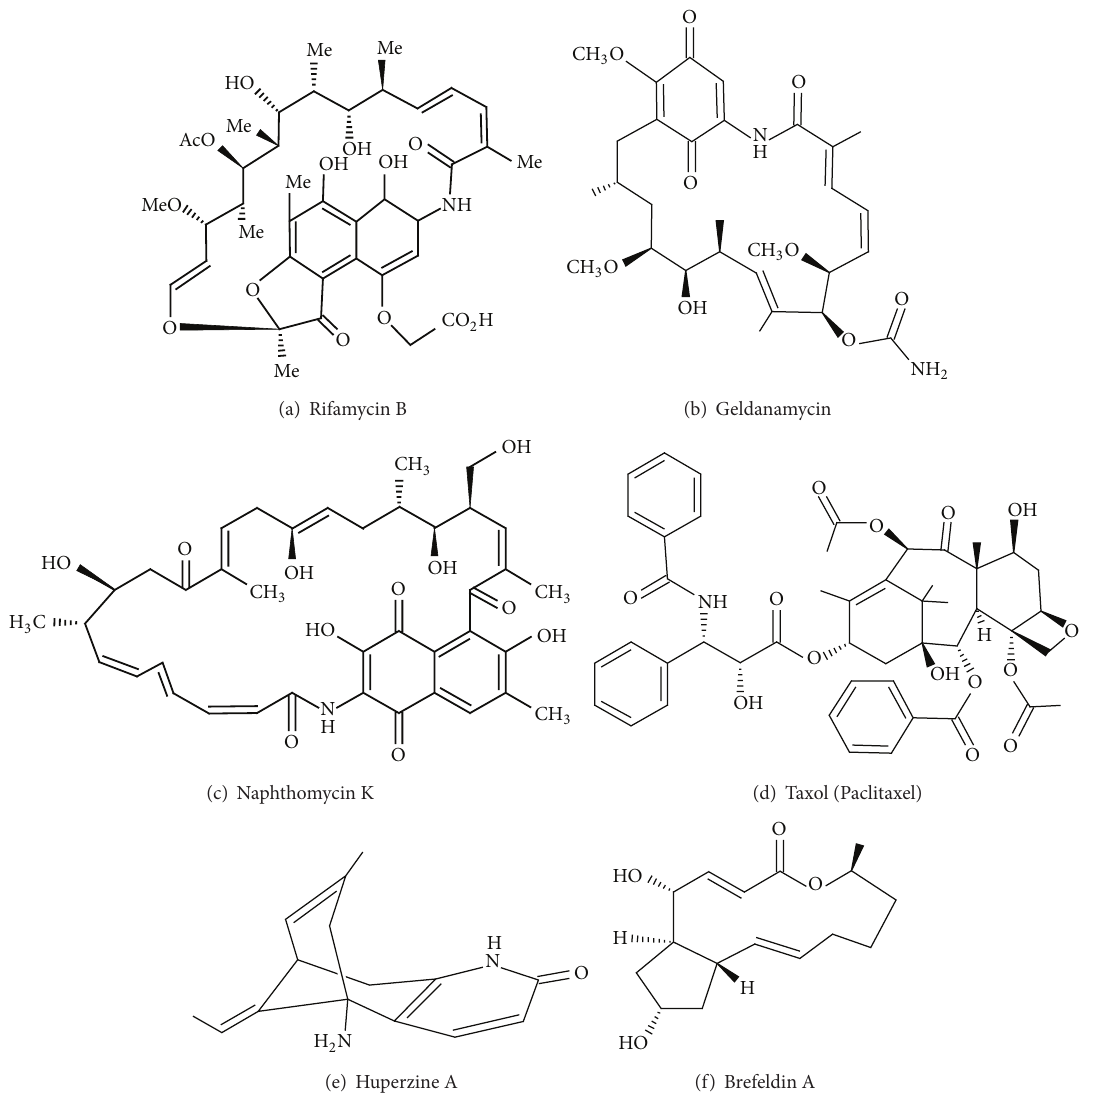
Figure 1: Chemical structures of some bioactive compounds produced by endophytic microorganisms.